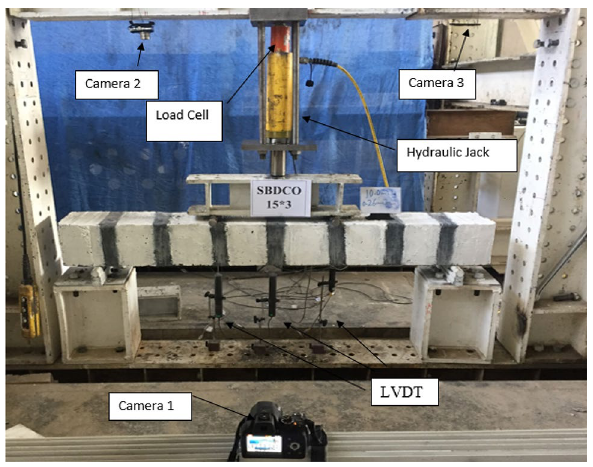
Fig. 1 Details of the test setup and location of cameras and LVDTs